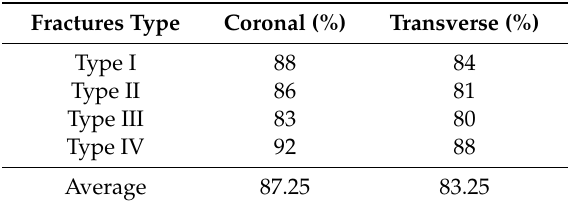
Table 1. Accuracy of the fractures type detection based on Sanders classification.